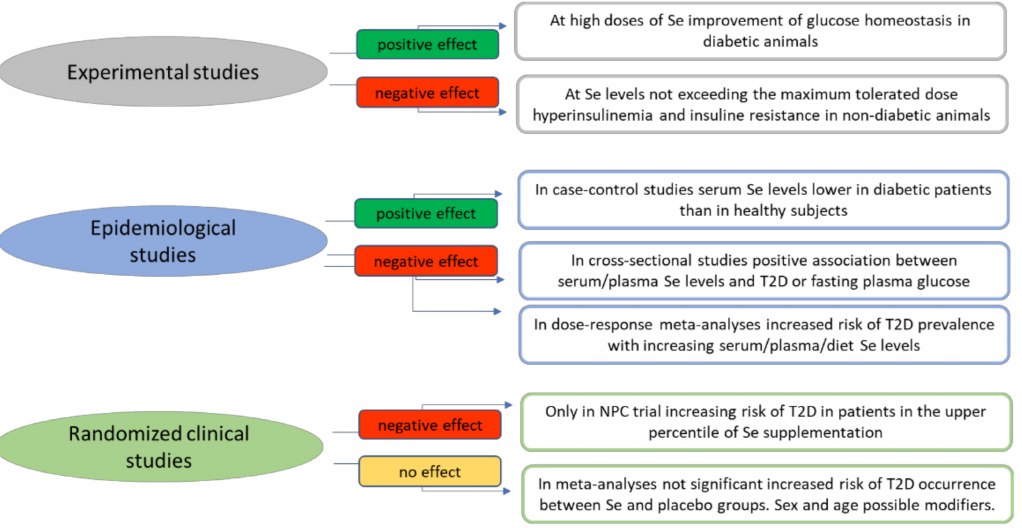
Figure 3. Summary of the current evidence derived from experimental, epidemiological and ran- domized clinical studies on the association between selenium and occurrence of type 2